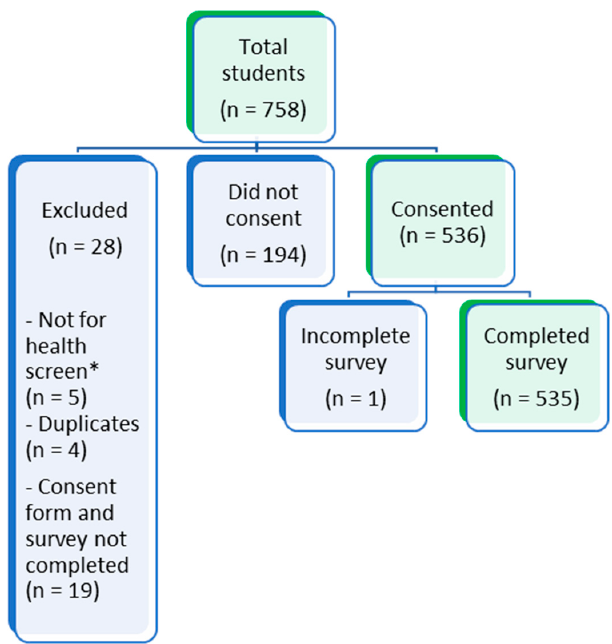
Figure 3. Flow diagram showing exclusion of study participants. (* students who attended clinic for other health related matters).